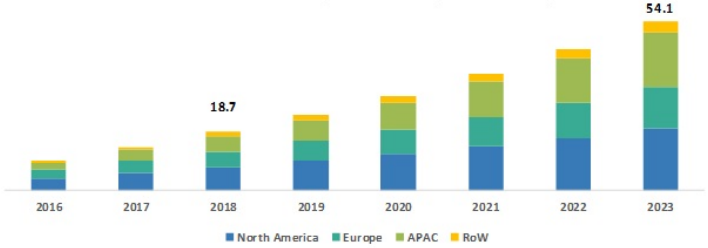
Figure 1. Growth of mobile robot market by region (billion USD). Reprinted with permission from ref. [2]. Copyright 2021 MarketsandMarkets Research Private Ltd.